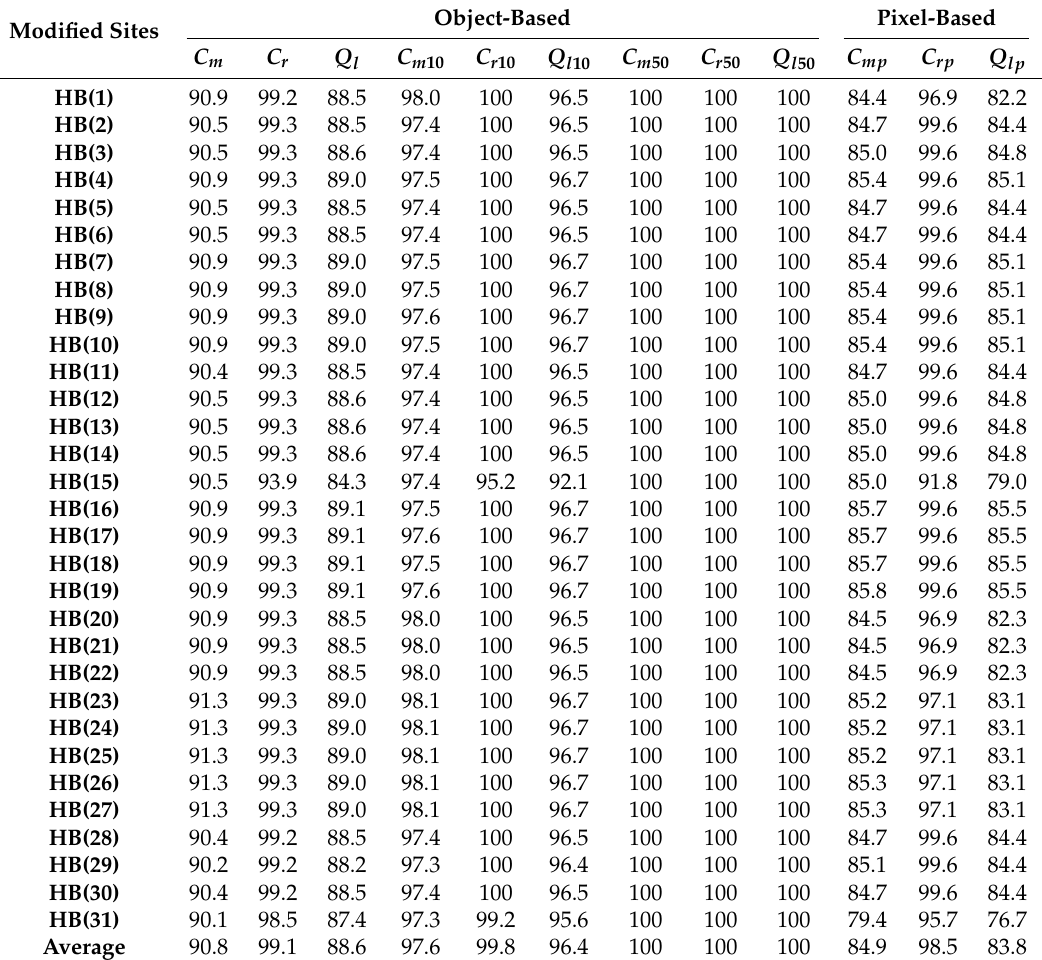
Table 5. Building change detection results for changes in the HB site. Object-based: C m , completeness; C r , correctness; Q l , quality ( C m , C r 10 Q l 10 and C m 50 , C r 50 Q l 50 are for building planes over 10 m 2 and 50 m 2 , respectively). Pixel-based: C mp , completeness; C rp , correctness; Q lp , quality are in